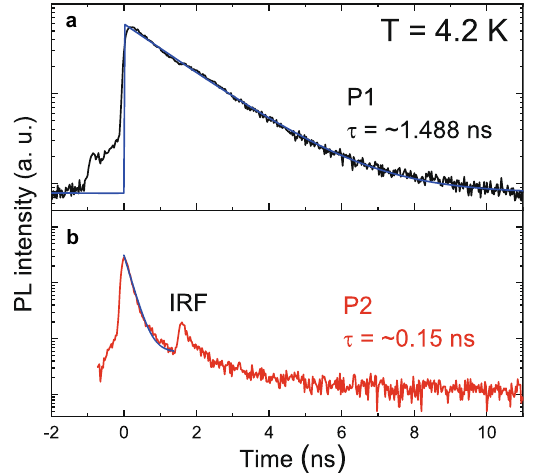
Fig. 3 Time-resolved photoluminescence. a Time-solved PL of the P1 (black solid line) and P2 (red solid line) emission peaks measured at 4.2 K. The blue solid lines are fi tted. The excitation power is 2 mW. b The shoulder near 1.6 ns is due to the instrument response function (IRF) caused by electron re fl ections in the system.